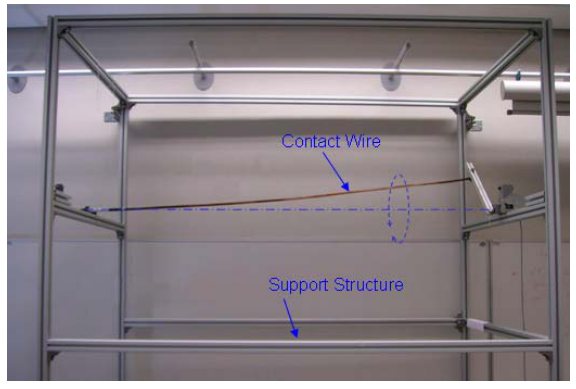
Figure 7. Structure assembled in order to generate contact wire movement.